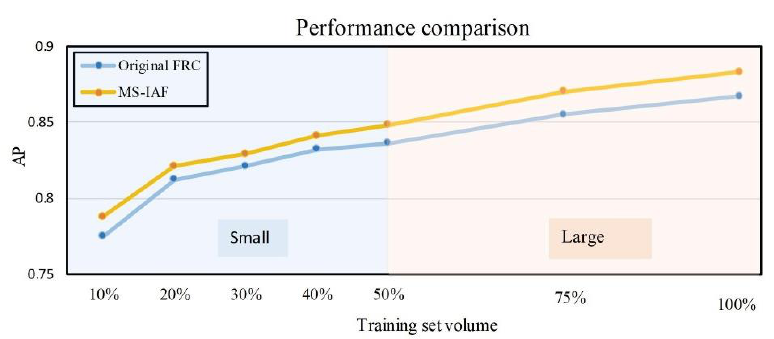
Figure 7. Performance difference between original FRC and MS-IAF models under different train- ing set (100% represents all these 6300 samples are used for training the model). set (100% represents all these 6300 samples are used for training the